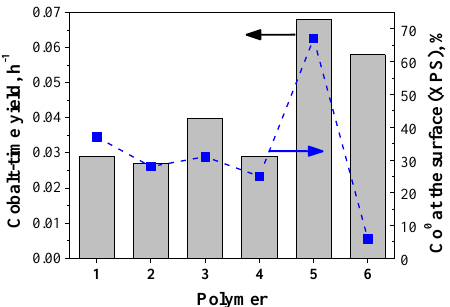
Figure 5. Correlation between the activity and the reduction degree at the surface of the CoNPs as a function of the polymeric stabilizer (Co 0 determined by XPS).